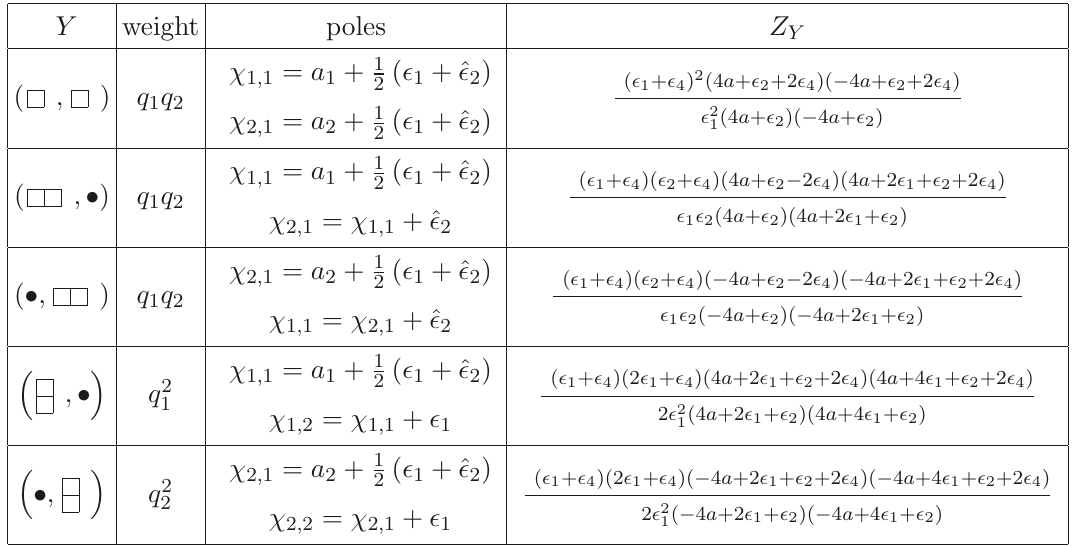
Table 2 . We list the tableaux, the weight factors, the pole structure and the contribution to the partition function in all five cases with two boxes for the SU(2)